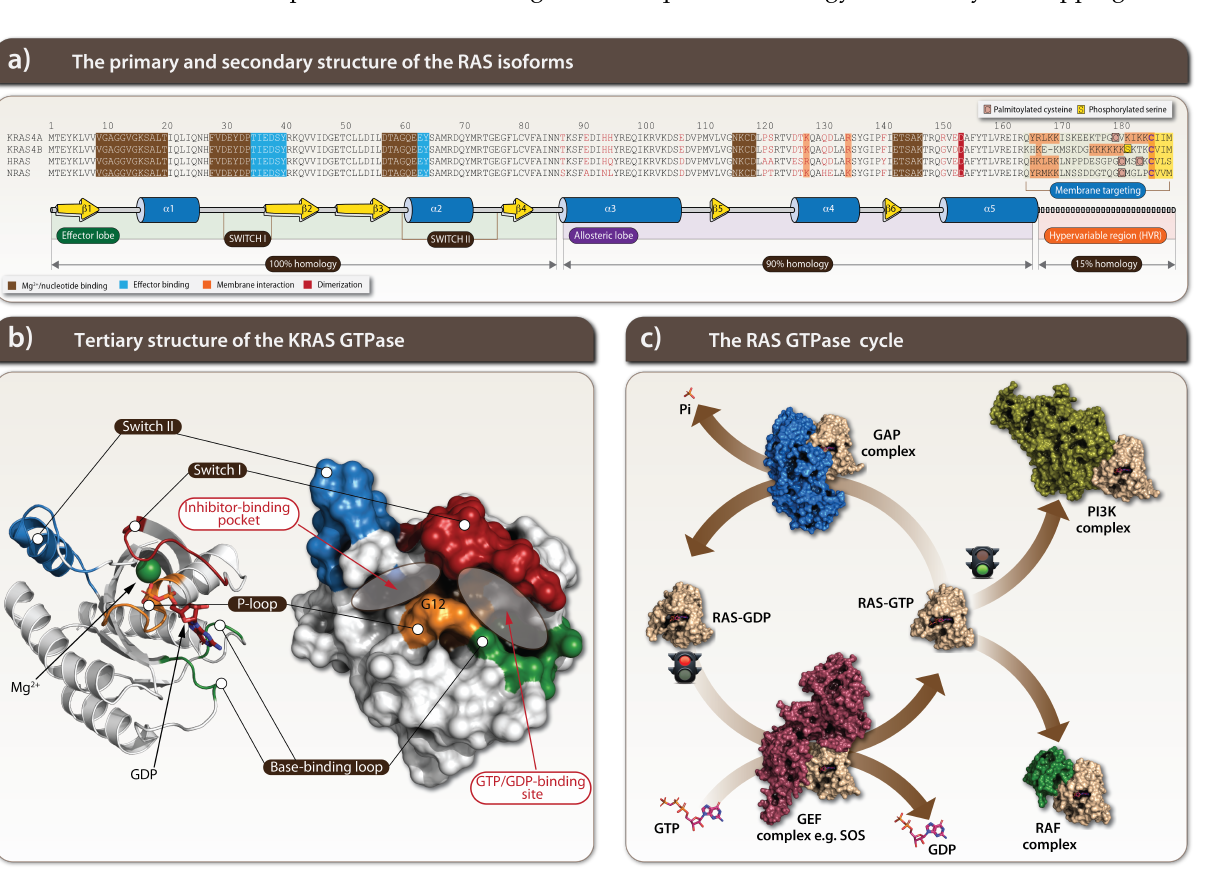
Figure 1. The human RAS small GTPase isoforms: HRAS, NRAS, KRAS4A and KRAS4B. ( a ) The human RAS isoforms share high homology in their primary and secondary structures. The multiple sequence alignment was done by CLUSTALW. The RAS G-domain has an effector lobe (100% homol- ogy), allosteric lobe (90% homology), and a hypervariable region (15% homology). The residues in the effector and allosteric lobes that do not share homology are highlighted in red. Important regions are shown in the sequence alignment as colored squares and are responsible for Mg 2+ /nucleotide-, effector-binding or membrane interaction and dimerization. The majority of residues in the hy- pervariable region are responsible for interaction of RAS isoforms with the cytosolic membrane and some of the cysteine and serine residues are post-translationally modified by palmitoylation or phosphorylation. The very last carboxy-terminal tetrapeptide CXXX motif undergoes isoprenylation. The KRAS GTPase contains five α -helices (blue cylinders) and six β -strands (yellow arrows). The